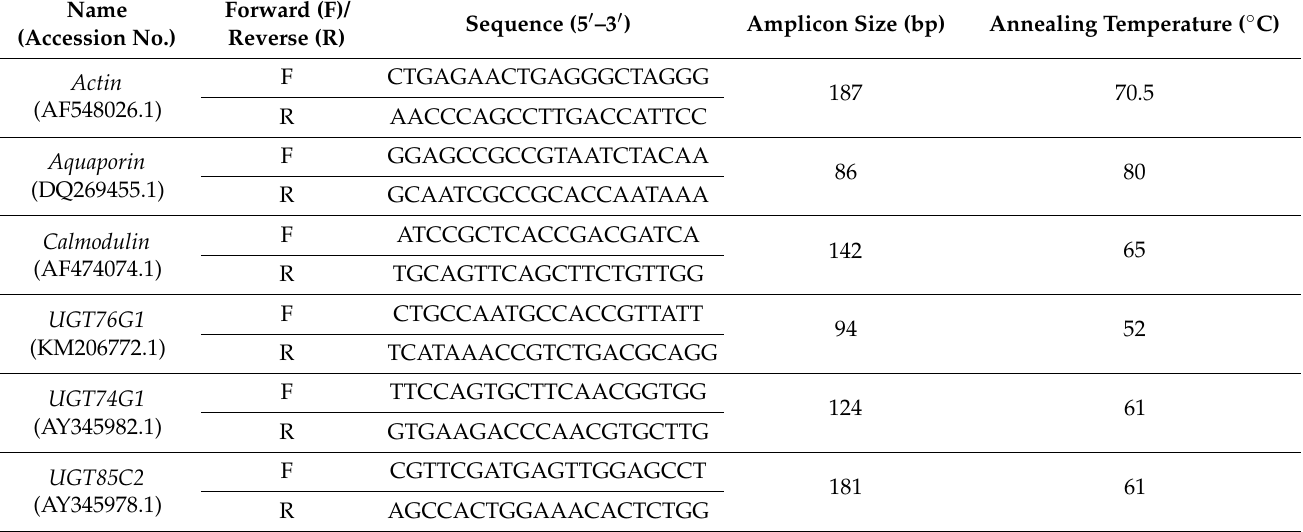
Table 3. Details of the designed primers used to detect the expression level of targeted and reference genes in RT